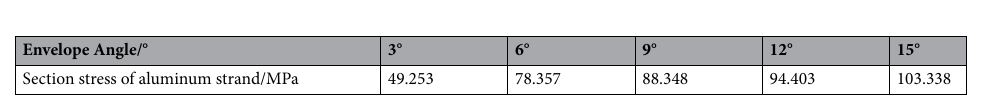
Figure 18. Equivalent stress cloud diagram of midpoint position of aluminum strand at tension load of 0kN ( a) Equivalent stress cloud diagram of aluminum strand at an envelope angle of 3°; ( b ) Equivalent stress cloud diagram at an envelope angle of 6°; ( c ) Equivalent stress cloud diagram at an envelope angle of 9°; ( d ) Equivalent stress cloud diagram of aluminum strand at an envelope angle of 12°; ( e ) Equivalent stress cloud diagram of aluminum strand at an envelope angle of 15°.